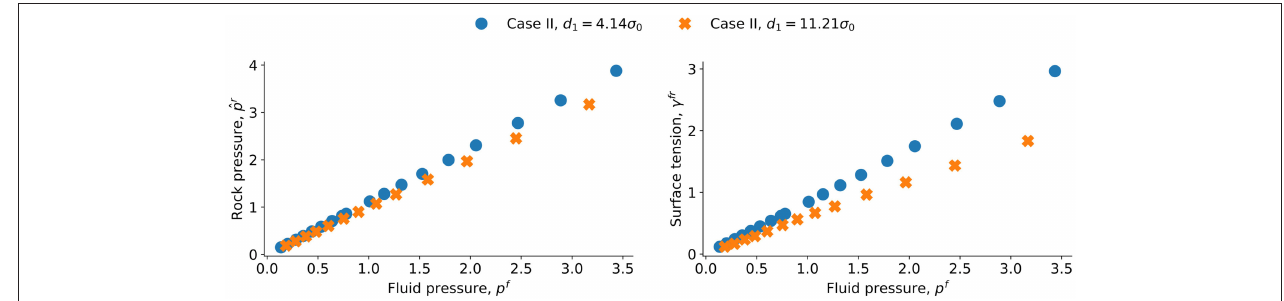
FIGURE 7 | Fitted grain pressure